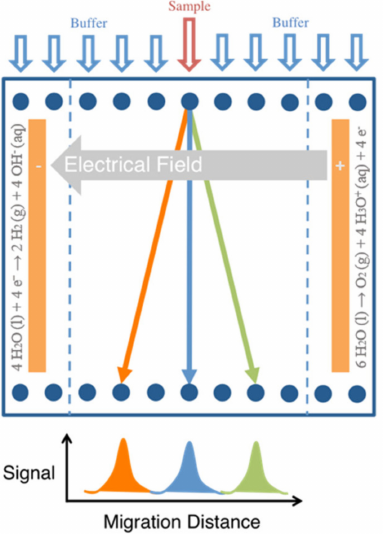
Figure 1. General principal of separation in free-flow electrophoresis, where a sample stream is continuously fed into the separation chamber and deflected laterally in an electric field based on the analyte’s electrophoretic